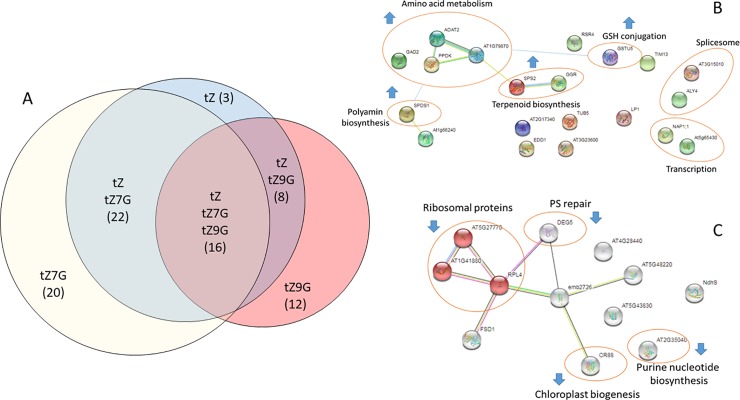
trans-Zeatin-N-glucosides alter the Arabidopsis proteome in a partially overlapping manner with trans-Zeatin.A, Proportional Venn diagram showing number (in parentheses) of differentially expressed proteins after two-hour treatment of 10dag WT Arabidopsis seedlings with 1μM hormone. B, Treatment with tZ7G affects amino acid metabolism, terpenoid biosynthesis, and other pathways. C, Treatment with tZ9G affects largely plastid proteins, including those involved in chloroplast biogenesis and photosystem (PS) repair.